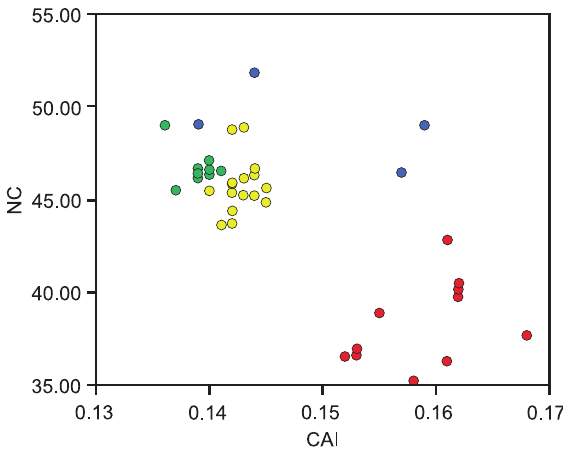
Figure 6. Codon usage in hexacorallian anthozoans. CodonW [73] was used to estimate codon usage biases; default settings were used in calculation of the codon adaptation index. NC: effective codon number. CAI: codon adaptation index. Colour coding and taxon choice is as shown in Figure 2.